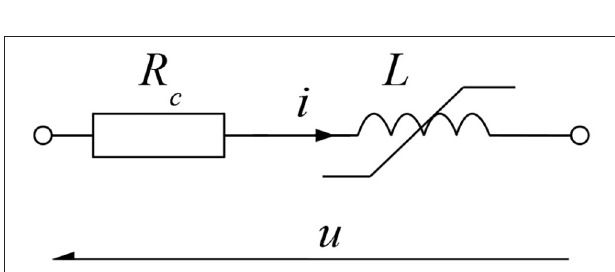
FIGURE 2 | Block diagram of the proposed inductor model—reproduced from Gołdasz et al. (2018a) under the CC BY 4.0